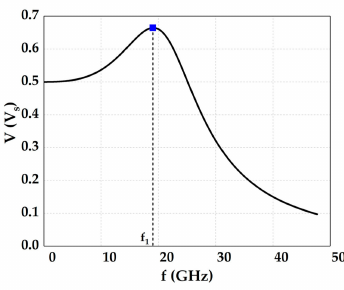
Figure 5. Voltage-frequency characteristics of the point Q